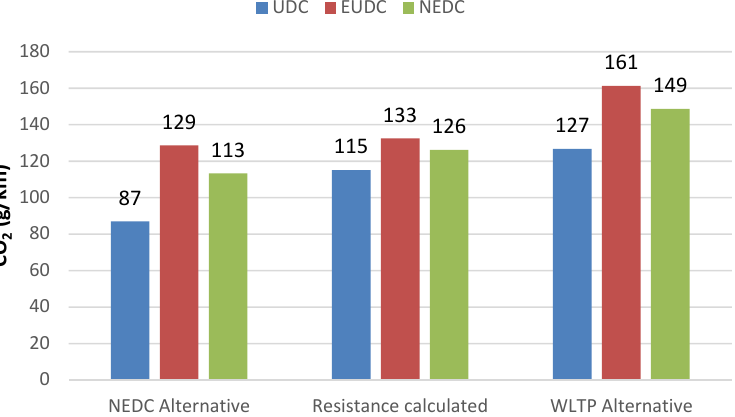
Figure 3. Comparison of CO 2 emissions for the analysed dynamometer load setting methods, in urban (UDC) and extra-urban (EUDC) phases and for the entire NEDC cycle.